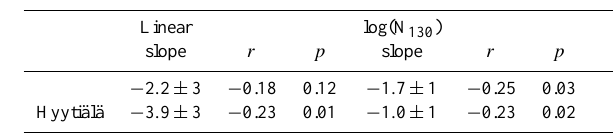
Table 6. Slopes and corresponding 95% confidence intervals, corre- lation coefficients and p values of the relationships shown in Fig.